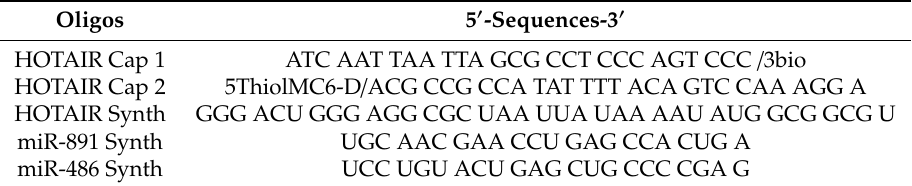
Table 1. Oligonucleotide sequences used in experiments. Oligos 5 (cid:48) -Sequences-3